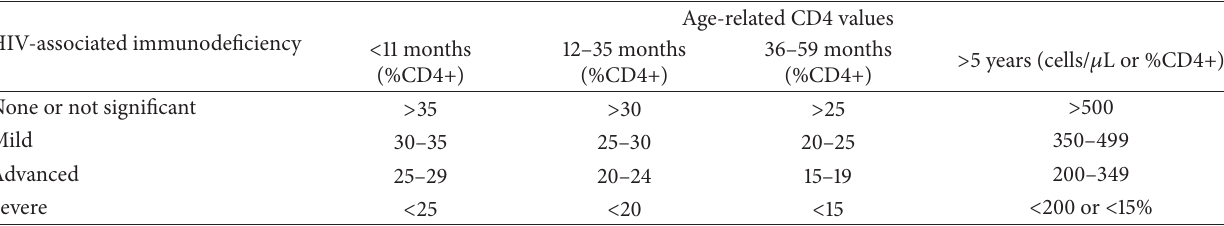
Table 1: WHO staging of HIV based on CD4 cells count.